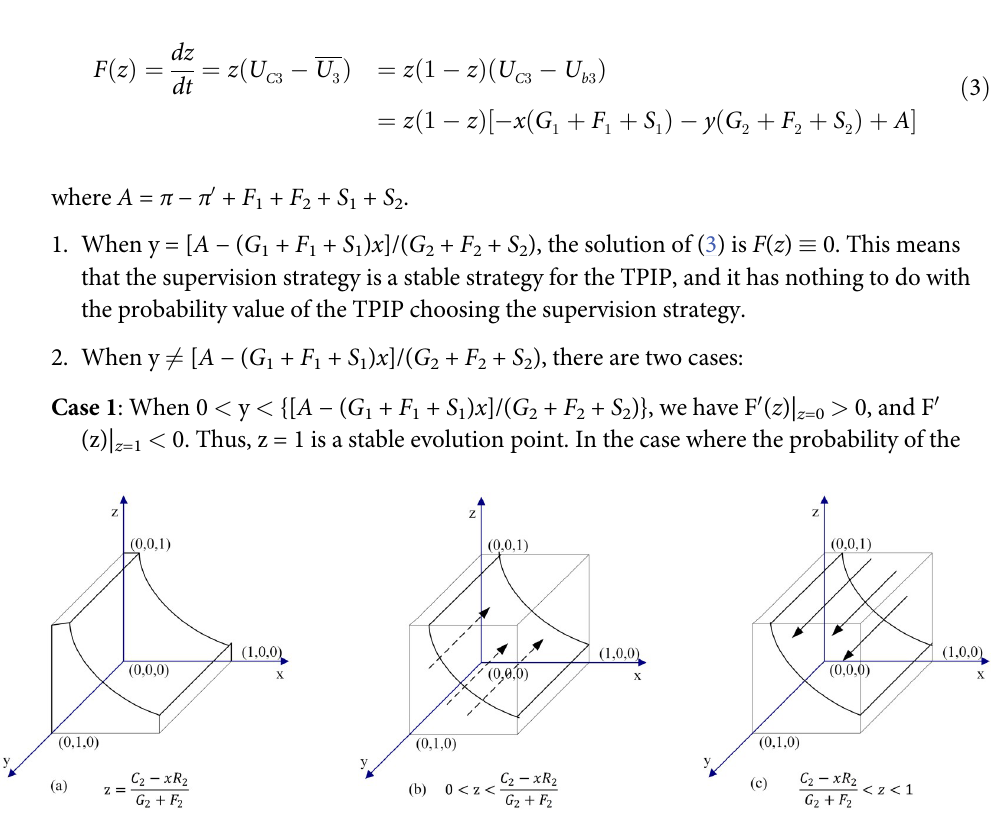
Fig 3. Dynamic evolution chart of DCs’